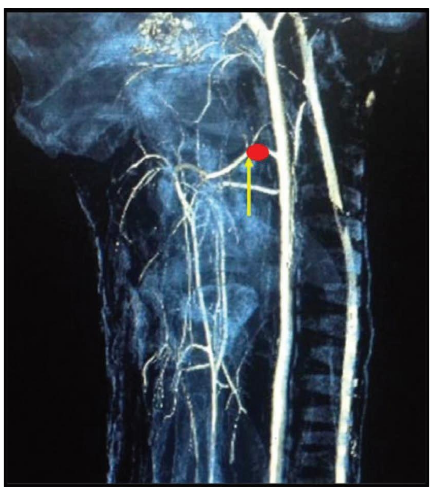
Figure 2: Position of Doppler sample volume in the anastomotic artery on the CT